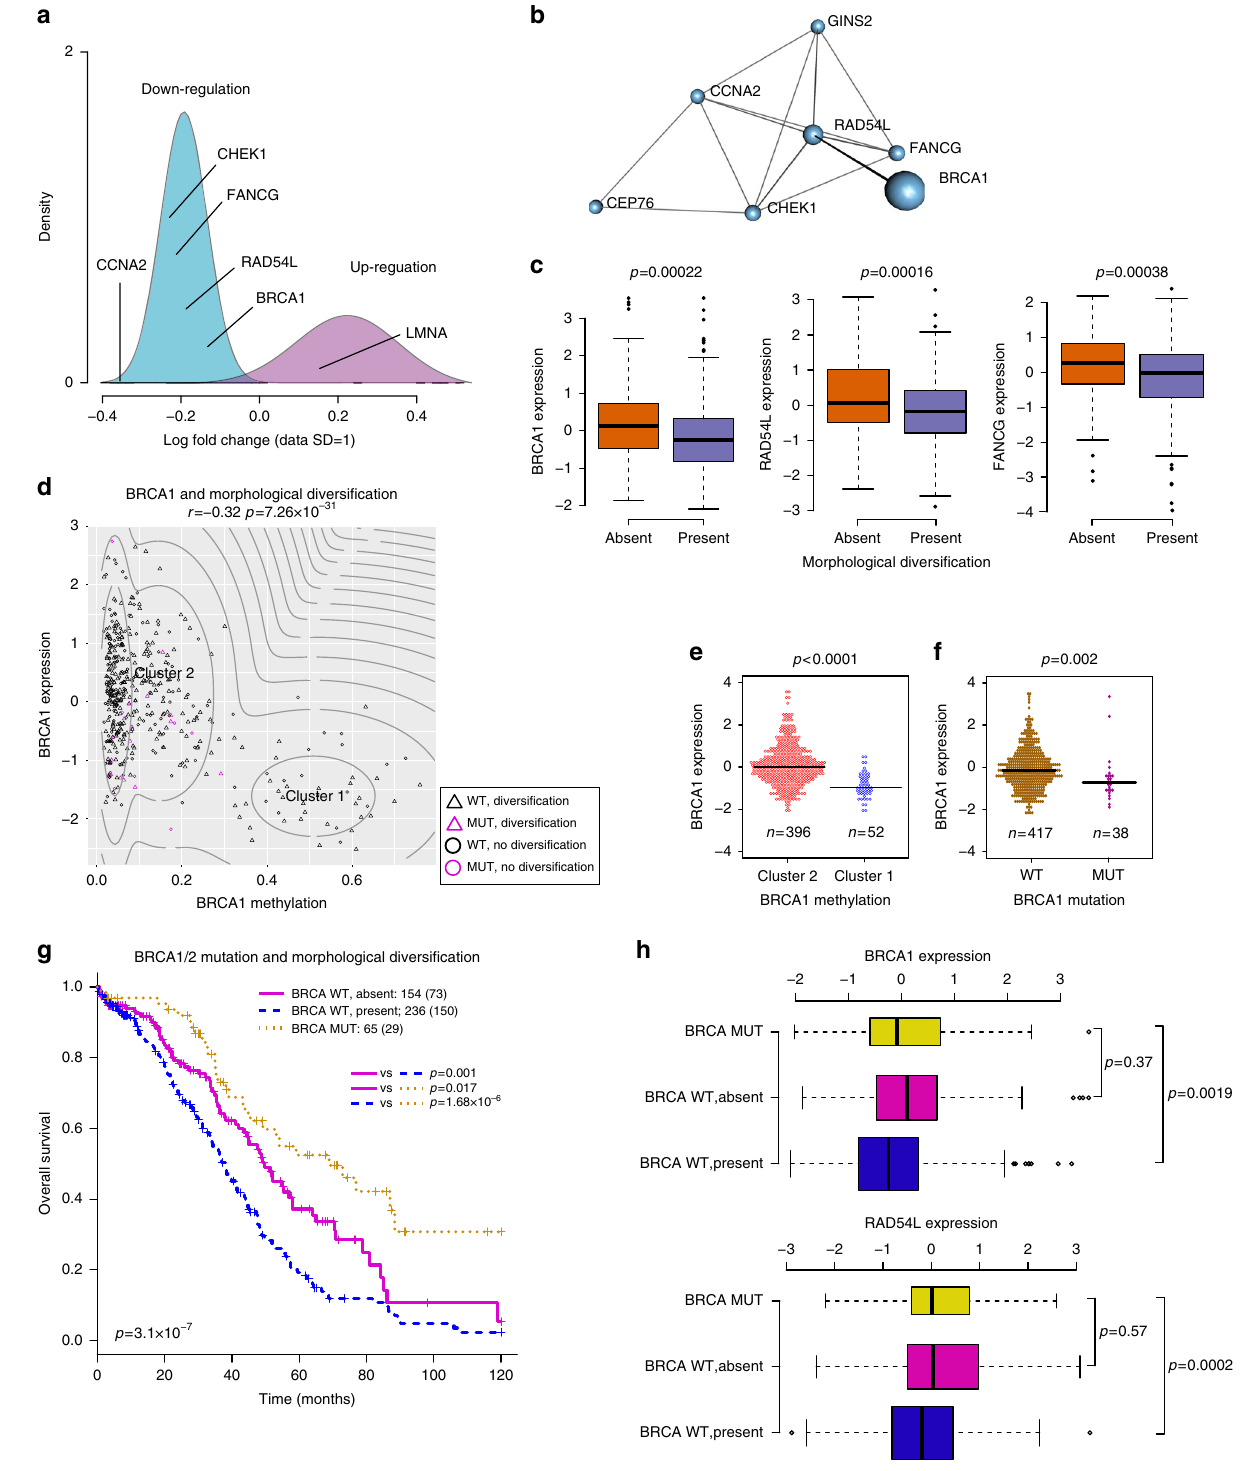
Fig. 3 Cancer morphological diversi fi cation and DNA repair. a Density plot showing the distribution of log-fold change in gene expression that signi fi cantly differed between diversi fi ed and non-diversi fi ed samples. Two clusters were identi fi ed using Gaussian mixture models, which represented down- and up- regulated gene clusters. b The gene module formed by highly co-expressed genes (cor > 0.38, p < 0.001) within the top 10 genes in the differential expression analysis. c Boxplots to illustrate the difference in BRCA1 , RAD54L and FANCG expression in samples with and without diversi fi cation. d Scatterplot illustrating the distribution of BRCA1 expression according to BRCA1 methylation status with contours from unsupervised clustering identifying the BRCA1 epigenetically silenced group (Cluster 1). e Beeswarm plot to show the distribution of BRCA1 expression in the two clusters shown in d . f Beeswarm plot to show signi fi cantly lower expression of BRCA1 in a small number of samples with BRCA1 mutation (germline and somatic). g Kaplan- Meier curves depicting the differences in OS for patients strati fi ed by BRCA1/2 mutation status (wildtype WT or mutated MUT) and morphological diversi fi cation. h Boxplots showing the differences in BRCA1 and RAD54L expression according to the three patient groups in